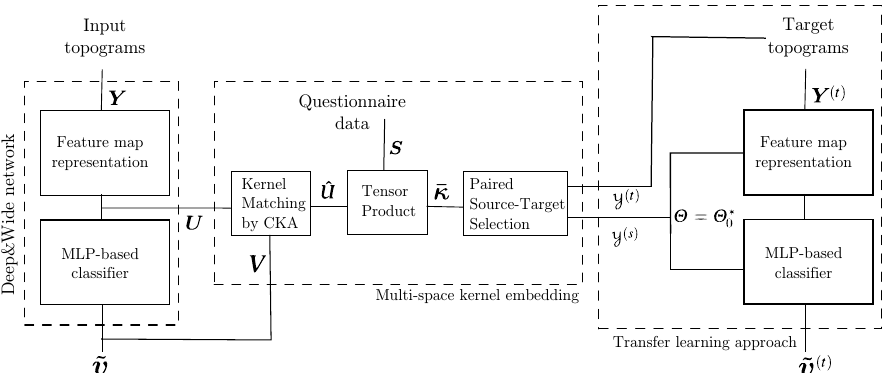
Figure 1. Guideline of the proposed transfer learning approach, including Stepwise Kernel Matching to combine data from Electroencephalography and Psychological